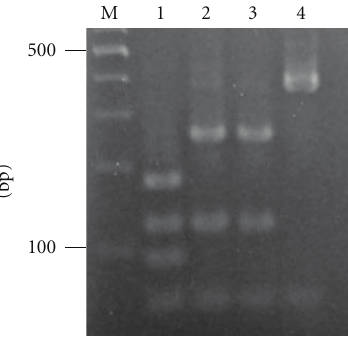
Figure 2: RFLP-PCR analyses of 18S rRNA genes of P. argentipes , two Sergentomyia species, and P. papatasi . PCR amplification with Lu.18S 1S and Lu.18S 1R primers was performed to amplify approximately 450bp fragments of sand fly 18S rRNA gene. The PCR products were digested with Hin fI, and the digested samples were separated by electrophoresis in a 3% agarose gel to produce DNA fragments. Lane M; 100-basepair ladder, lane 1; P. argentipes , lane 2; Sergentomyia species A, and lane 3; Sergentomyia species B. Lane 4; P.